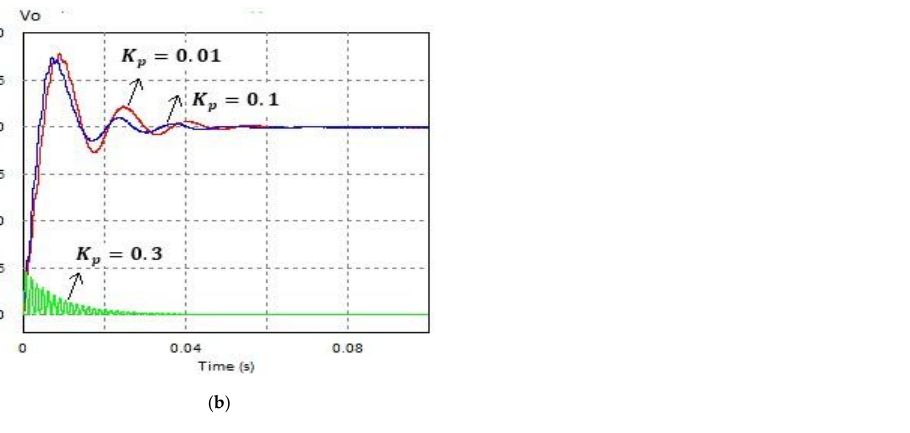
Figure 4. Output response for varying controller gains. ( a ) Output response for varying K i ; ( b ) Output response for varying K p .